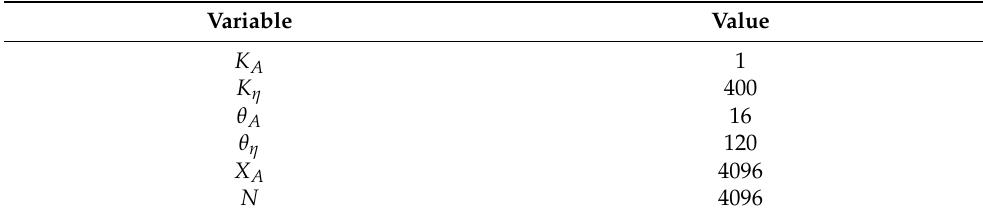
Table 4. Parameters used in practice.